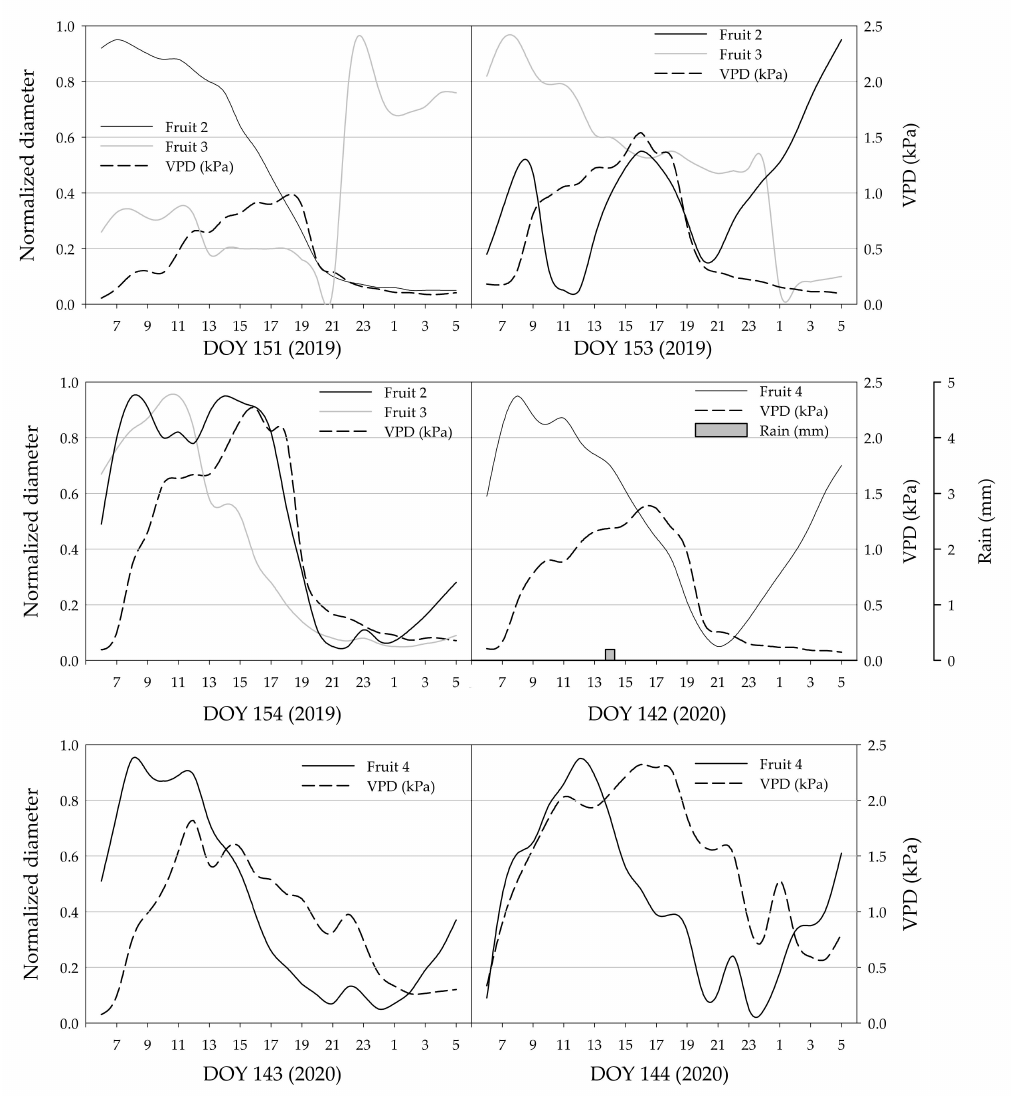
Figure 4. Most representative daily trends of transversal diameter, VPD and rain in the second periods (growth stage 4)